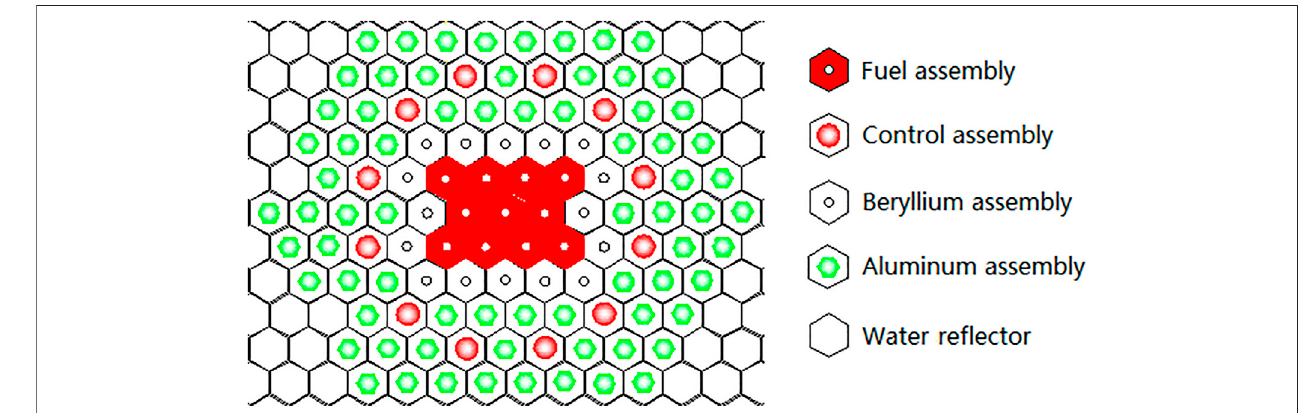
FIGURE 7 | Core arrangement of Scheme 6.